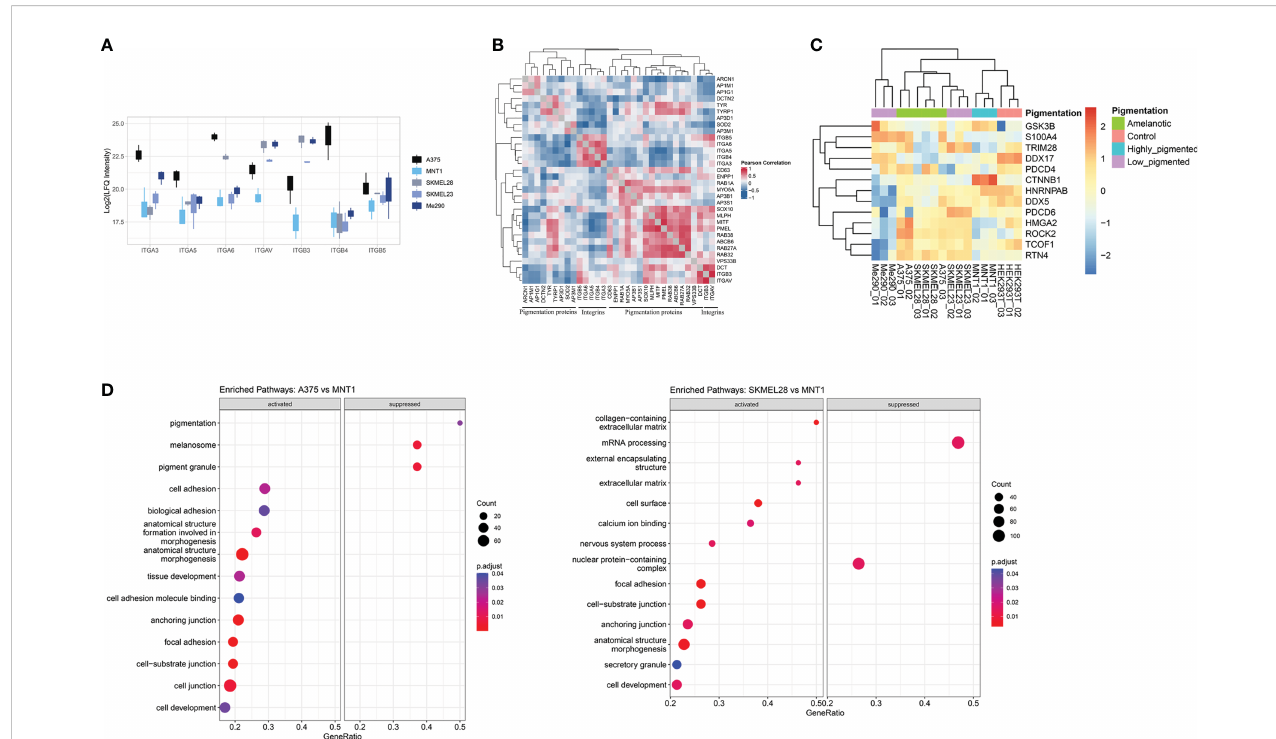
FIGURE 3 Proteins involved in cellular adhesion process are downregulated in highly pigmented melanoma cells. (A) Box plot of log2 transformed LFQ intensity of selected integrins showing the differences between cell lines and a prevalence of integrins to have an increased expression in A375 cell line. (B) Pearson ’ s protein-protein correlation matrix of integrins and proteins annotated for pigmentation (GO:0043473). (C) Heatmap of log2 transformed LFQ intensity values of proteins related to epithelial to mesenchymal transition (GO:0001837) identi fi ed in our proteomic data. This set of proteins differentiate low migrating cells (Me290 and MNT1) from the more aggressive counterparts, A375, SKMEL28 and SKMEL23. (D) Dot plots showing the results of GSEA analysis associated with “ biological process ” , “ molecular function ” and “ cellular component ” terms (p.adjust<0.05), coming from the pairwise comparison between amelanotic (A375 and SKMEL28) and highly pigmented cells (MNT1) (Supplementary Table 1, GSEA A375 vs MNT1 and GSEA SKMEL28 vs